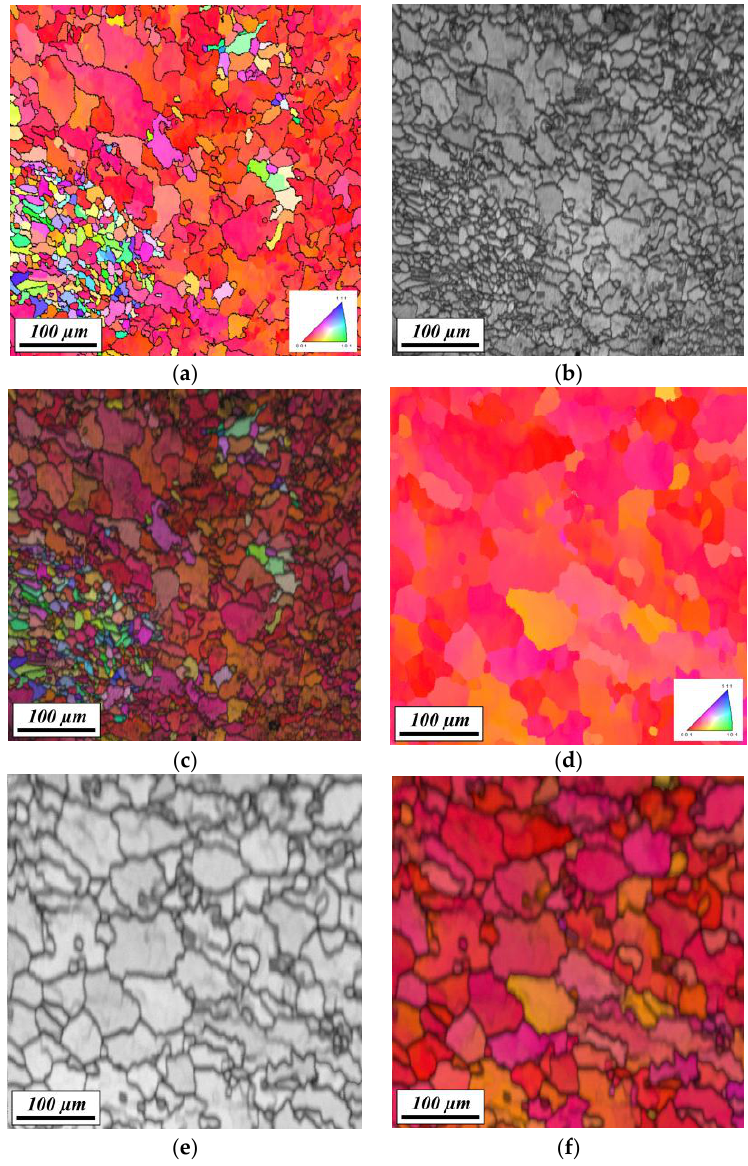
Figure 4. EBSD results: ( a – c ) SEBM Specimen A; ( d – f ) SEBM Specimen B; ( a , d ) IPF-maps; ( b , e ) IQ-maps; and ( c , f ) combined IPF/IQ-maps.